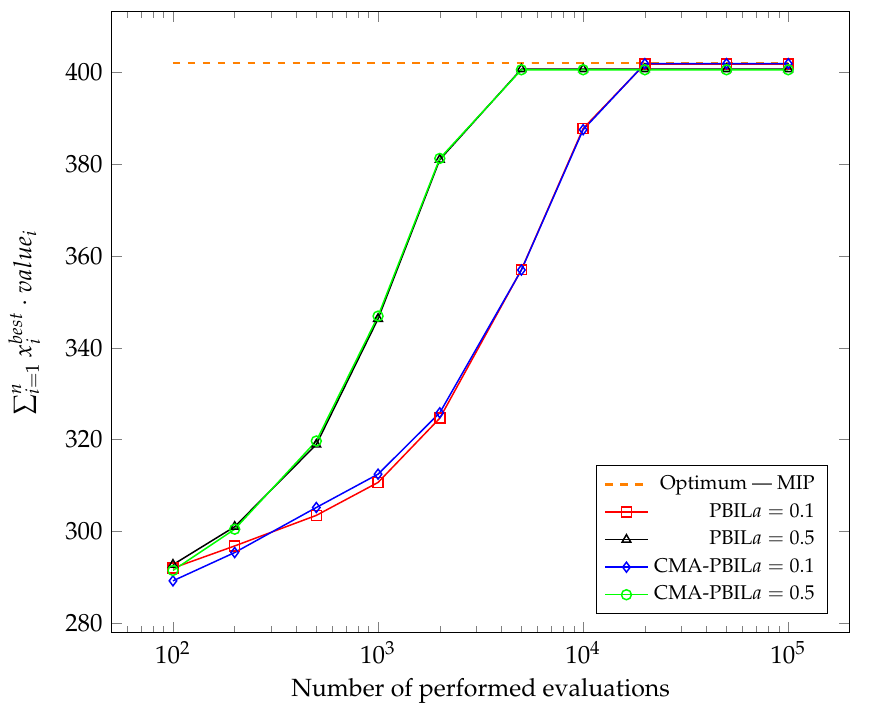
Figure 2. The average of the maximal values of the objective function calculated so far, test case no 2.